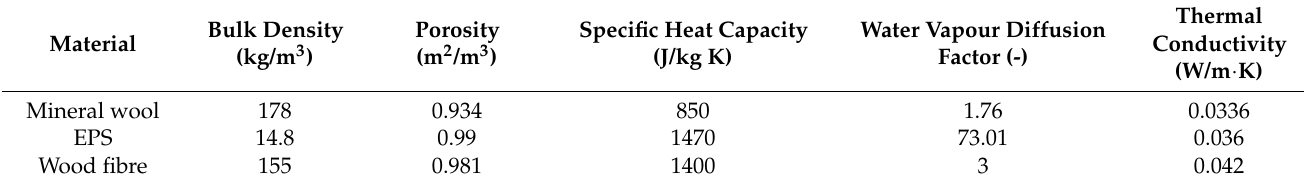
Table 5. Hygrothermal properties of insulation material used in the WUFI simulation.